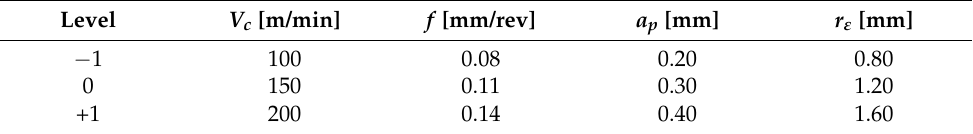
Table 1. Factors and their levels used in the numerical model.